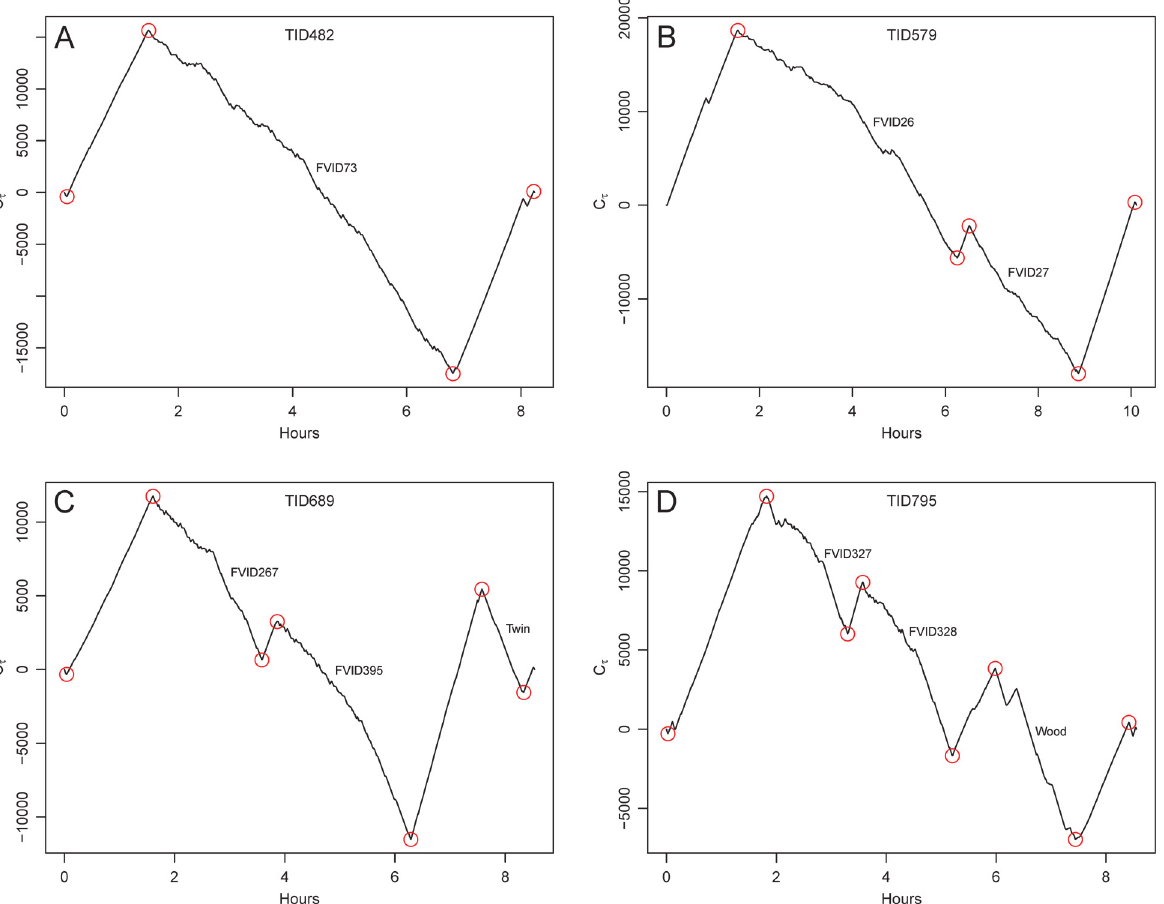
Fig 6. Cumulative sum time series plots generated from Equation 1. Plots are for the trips in Fig. 2. Local maxima and minima are indicated by the red circles, corresponding to points where the track changes between travel and ARS. Segments with positive slope are all travel. Segments with negative slope are ARS and are annotated to indicate patch type identified by observers during trips. FVID indicates a FAD visit identification number.